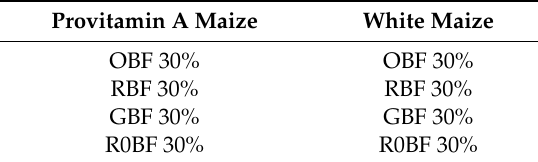
Table 1. Partitioning of maize